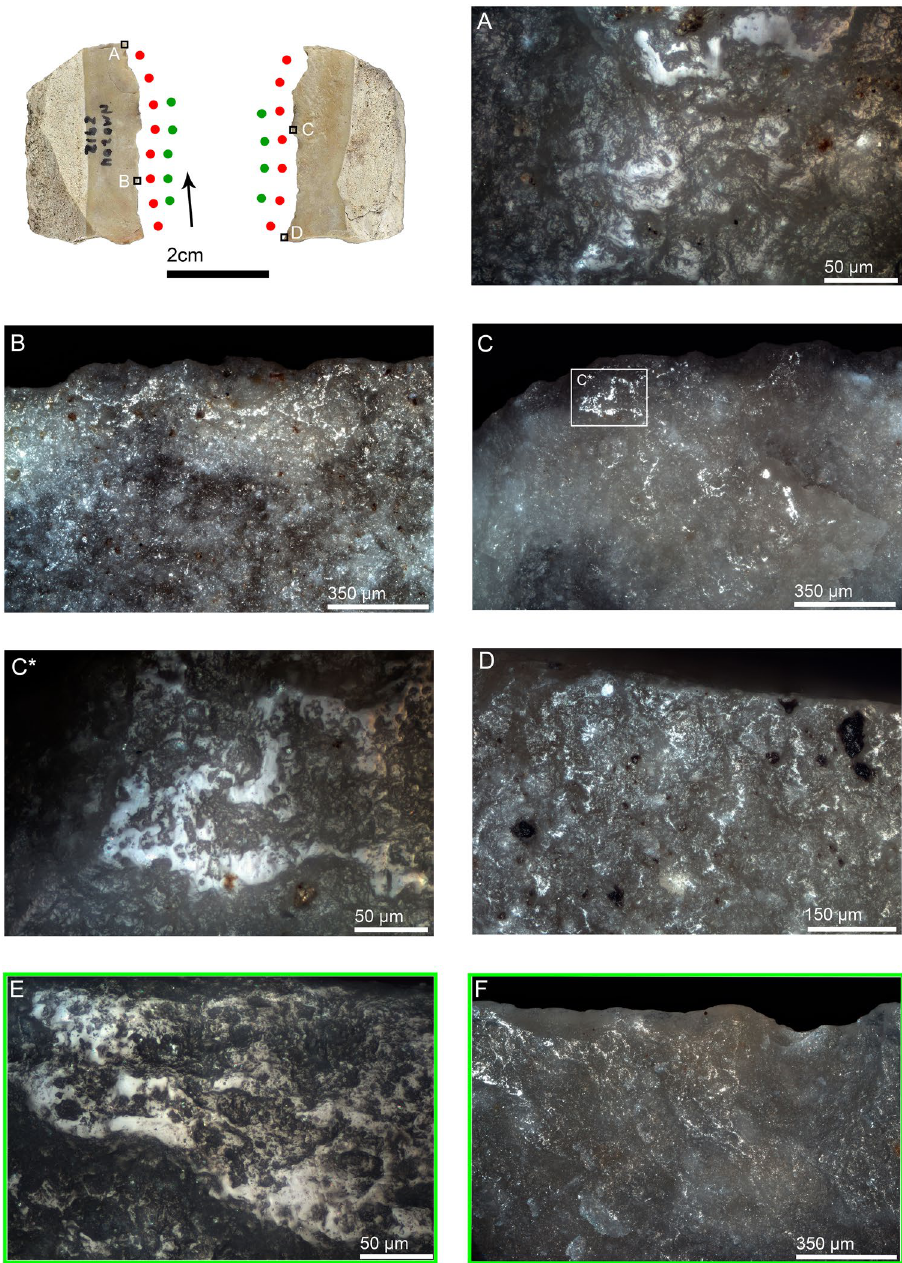
Figure 5. Naturally backed knife NMO11 2912 interpreted as a dry hide-cutting tool. ( A ) smooth polish associated with rough-dull polish and parallel striations on the dorsal distal right edge, 500 ×; ( B ) scalar scars with feather termination and polish on the dorsal proximal right edge, 100 ×; ( C ) scalar scars with feather termination and invasive polish on a protruding part of the ventral distal right edge, 100 ×; ( C* ) close-up of the previous picture showing the smooth texture and micro-wavy topography of well-developed polish, 500 ×; ( D ) invasive polish on the ventral proximal right edge, 200 ×; ( E ) well-developed smooth polish showing micro- wavy topography and pits on the ventral distal left edge of the experimental tool EXP-NMO25-P, used for cutting dry hide, 3172 strokes, 45 min, 500 ×; ( F ) scalar scars with feather termination associated with invasive polish on the ventral distal left edge of experimental tool EXP-NMO17-P, used for cutting dry hide, 2720 strokes, 40 min, 100